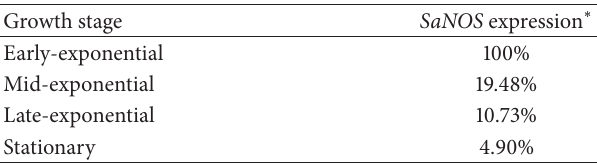
∗ Expression of SaNOS is shown relative to its transcript level during early-